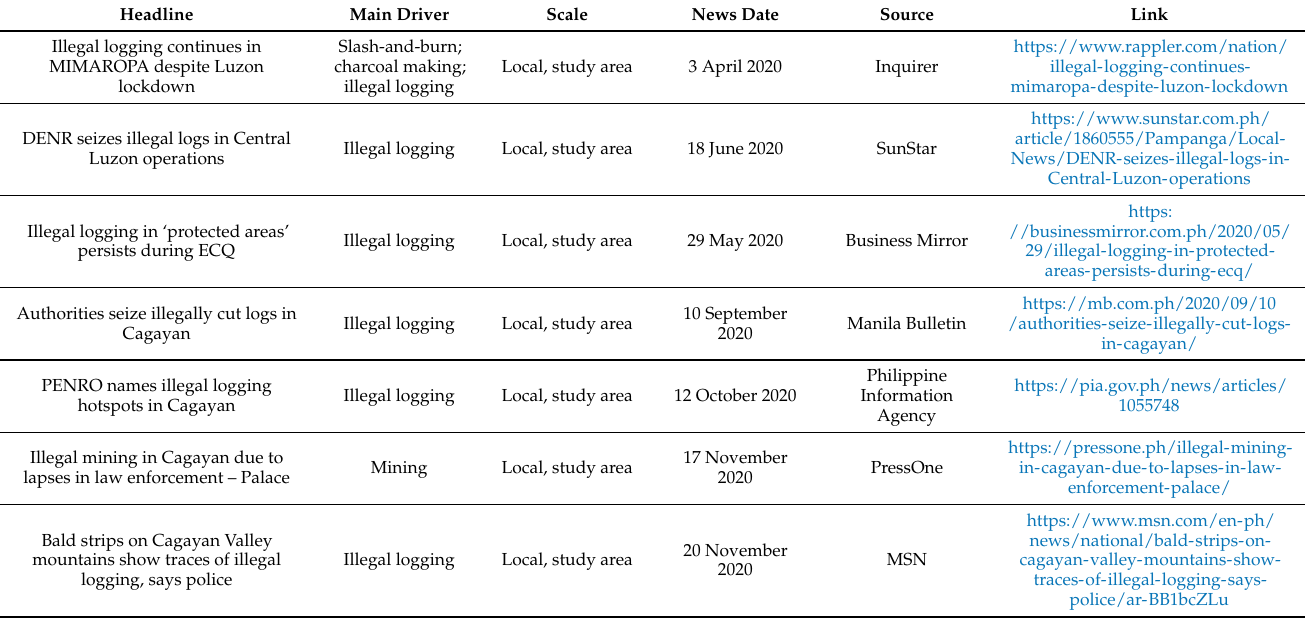
Table A1. List of news of reported illegal forest activities in the study area last